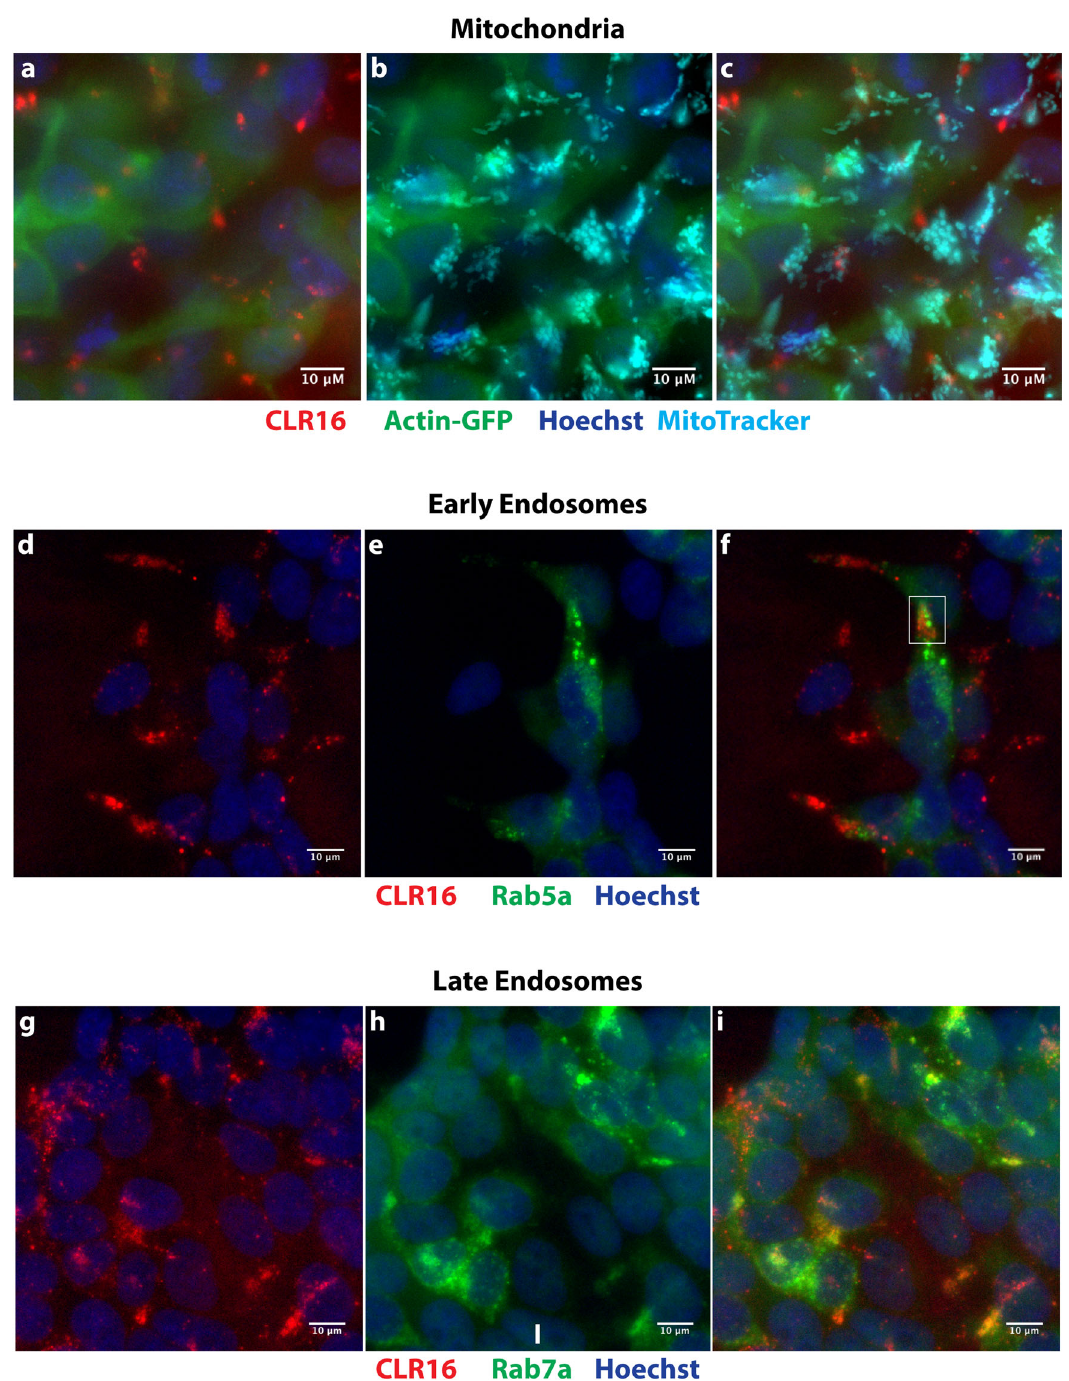
Fig. 3 CLR16 colocalizes partially with endosomes but not mitochondria. SH-SY5Y cells were incubated with CLR16 for 24 h in the presence of speci fi c markers for the different organelles. a Cells were transiently transfected with GFP-actin, incubated with 5 µ M CLR16, and nuclei were stained with Hoechst. b Mitochondria were stained with MitoTracker ™ Deep Red FM. c Overlap of a and b shows that CLR16 does not colocalize with mitochondria. d Cells were incubated with 5 µ M CLR16 and nuclei were stained with Hoechst. e Early endosomes were visualized by transient transfection with Rab5a-GFP. f Overlap of d and e shows that CLR16 colocalizes minimally with early endosomes (highlighted in a white box). g Cells were incubated with 5 µ M CLR16 and nuclei were stained with Hoechst. h Late endosomes were visualized by transient transfection with Rab7a-GFP. i Overlap of g and h shows that CLR16 colocalizes partially with late membrane, we hypothesized that MTs are internalized via active known to inhibit micropinocytosis 29,30 by disrupting lipid rafts 31 and membrane ruf fl ing 30 , as well as destabilizing F-actin 30 . If endocytosis. To investigate this possibility, we incubated SH- CLR16 internalization requires active dynamin-dependent SY5Y cells with CLR16 in the absence or presence of increasing endocytosis, it would be expected to decrease dose-dependently concentrations of the dynamin inhibitor dynasore, which speci- fi cally blocks dynamin-dependent endocytosis. Dynasore is also with increasing dynasore concentration.